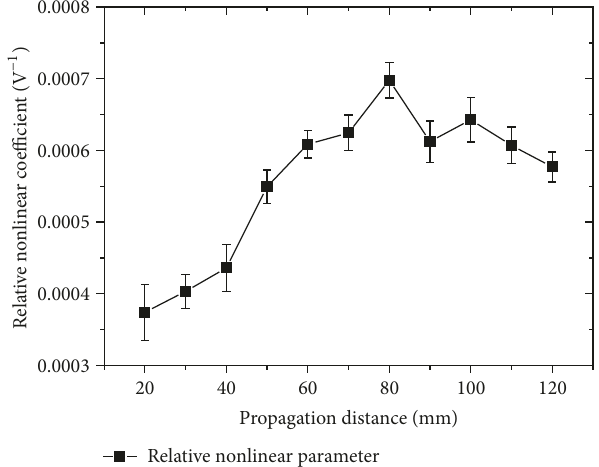
Figure 5: The relationship between the propagation distance and the relative nonlinear